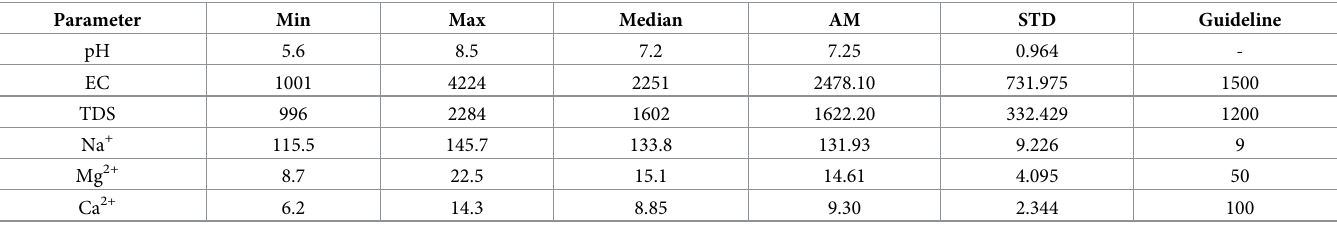
Table 1. Raw wastewater